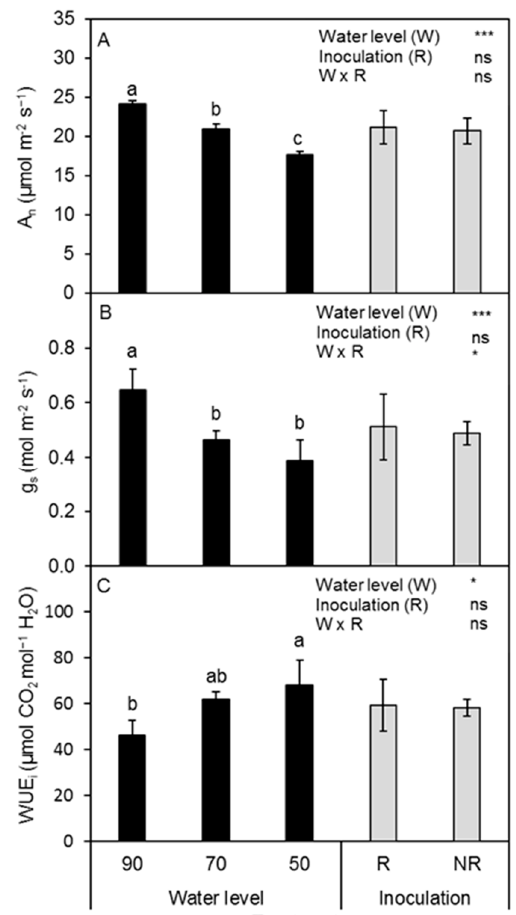
Figure 2. Effect of soil water regimes and rhizobia inoculation on ( A ) averaged photosynthesis (A n ), ( B ) stomatal conductance (g s ), and ( C ) intrinsic water use efficiency (WUE i ) of cowpea during the experimental period. 50, 70 and 90 denote 50%, 70%, and 90% of SWHC. R and NR indicate inoculation with and without rhizobia. Values are means ± SE (n = 8 for 90%, 70% and 50% of SWHC treatments and n = 12 for R and NR treatments). Different letters indicate significant differences in the experimental factor at p < 0.05 according to Duncan’s multiple range test.